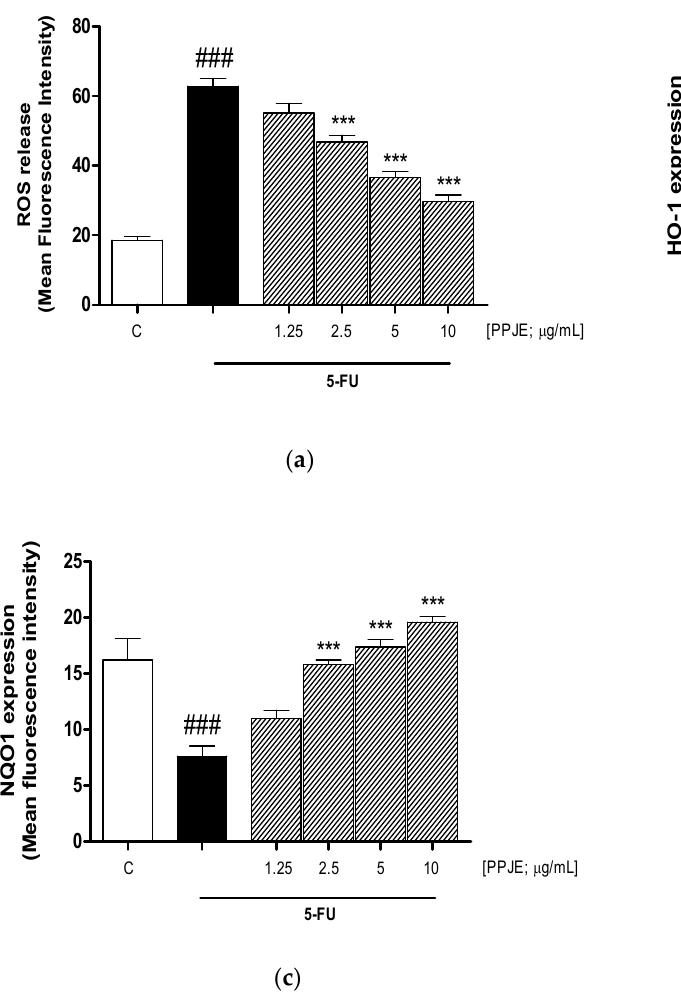
Figure 1. Effect of pomegranate juice extract (PPJE; 1.25–10 µg/mL) on intracellular ROS (reactive oxygen species) release ( a ), evaluated by means of the probe 2′,7′-dichlorofluorescin-diacetate (H 2 DCF-DA), and HO-1 ( b ) and NQO1 ( c ) expression, evaluated by cytofluorimetric technique, on HaCaT cells treated with 5-fluorouracil (5-FU; 10 µg/mL). Data are expressed as mean of fluorescence intensity. C denotes control group. ### denotes p < 0.001 vs. C; *** and * denote respectively p < 0.001 and p < 0.05 vs. 5-FU.